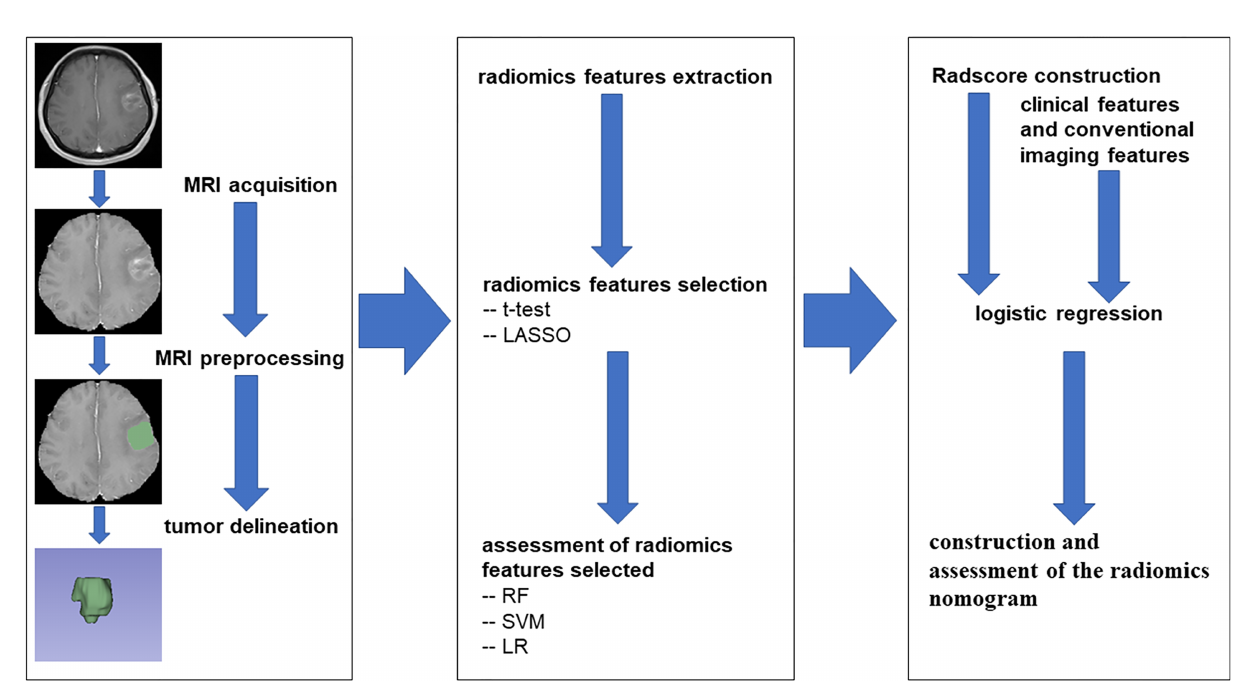
FIGURE 1 | The fl owchart of the